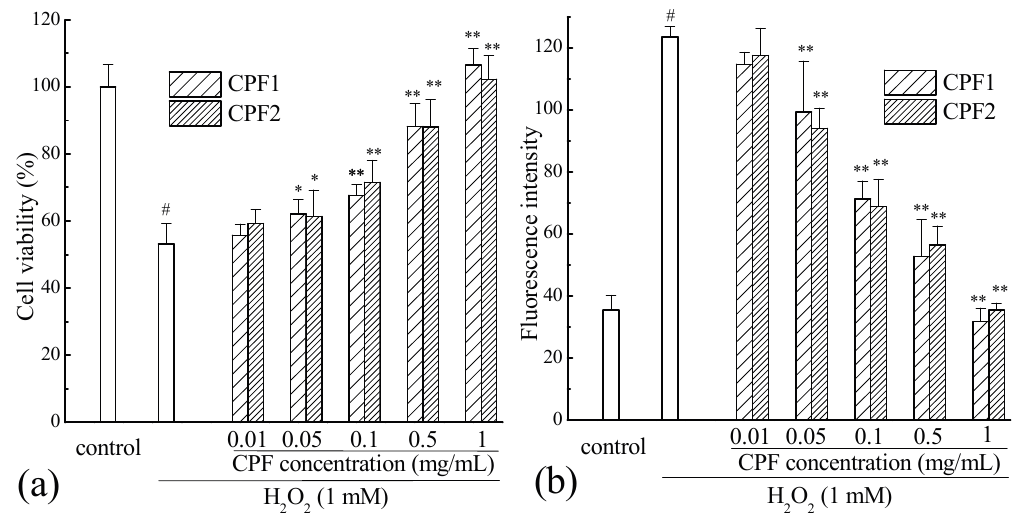
Figure 3. Cytoprotective effect ( a ) and intracellular ROS scavenging capacity ( b ) of CPF on Caco-2 cells from oxidative stress induced by H 2 O 2 . # p < 0.001 compared to control group, * p < 0.01 compared to damage group (only H 2 O 2 but no CPF treated